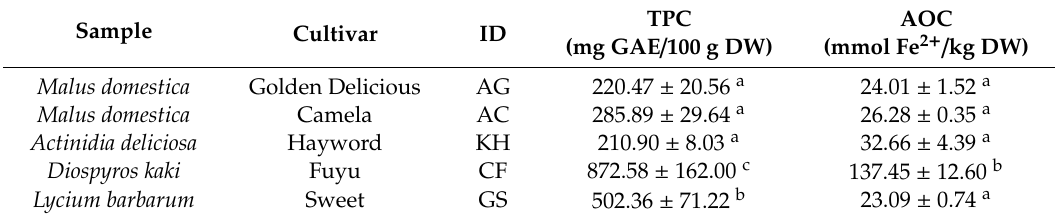
Table 1. Total phenolics (TPC) and antioxidant capacity (AOC) of analysed dried fruits.